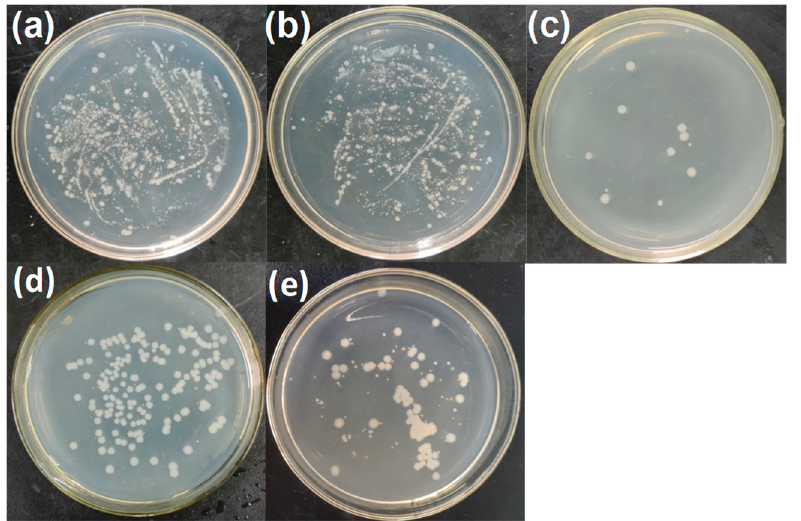
Figure 8. Evaluation of bactericidal effects. ( a ) Culturing result of the koi fish feeding water; ( b ) bactericidal effect of ZrO 2 /CB/coal-tar-pitch-SAC in irradiation of visible light; ( c ) bactericidal effect of 0.03-CuO/ZrO 2 /CB/coal-tar-pitch-SAC in visible light; ( d ) result of the water treated with the 0.15-CuO/ZrO 2 /CB/coal-tar-pitch-SAC; ( e ) result of the water treated with the 0.3-CuO/ZrO 2 /CB/coal-tar-pitch-SAC in visible light.